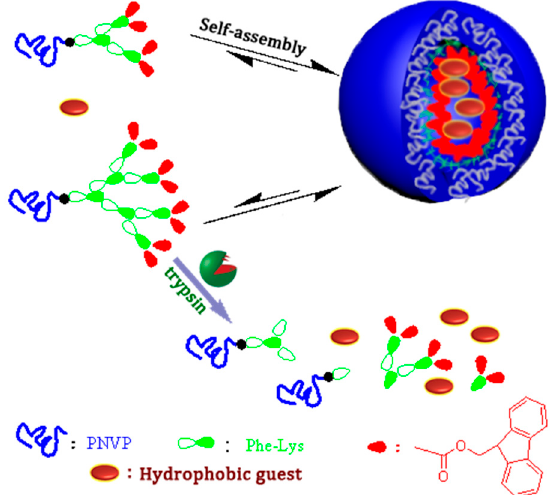
Figure 6. Schematic diagram of self-assembly and enzymatic hydrolysis of PNVP -b-dendr (Phe-Lys) n (n = 2, 3) with the same hydrophilic block.